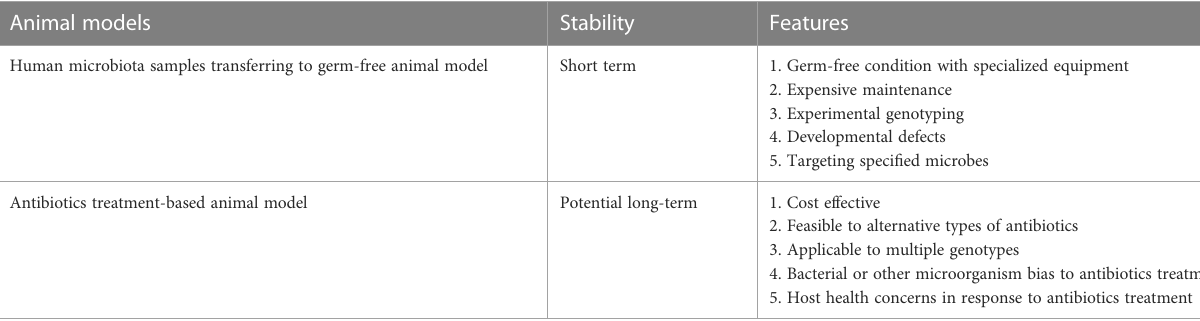
TABLE 2 Humanized microbiota-associated animal models. Animal models